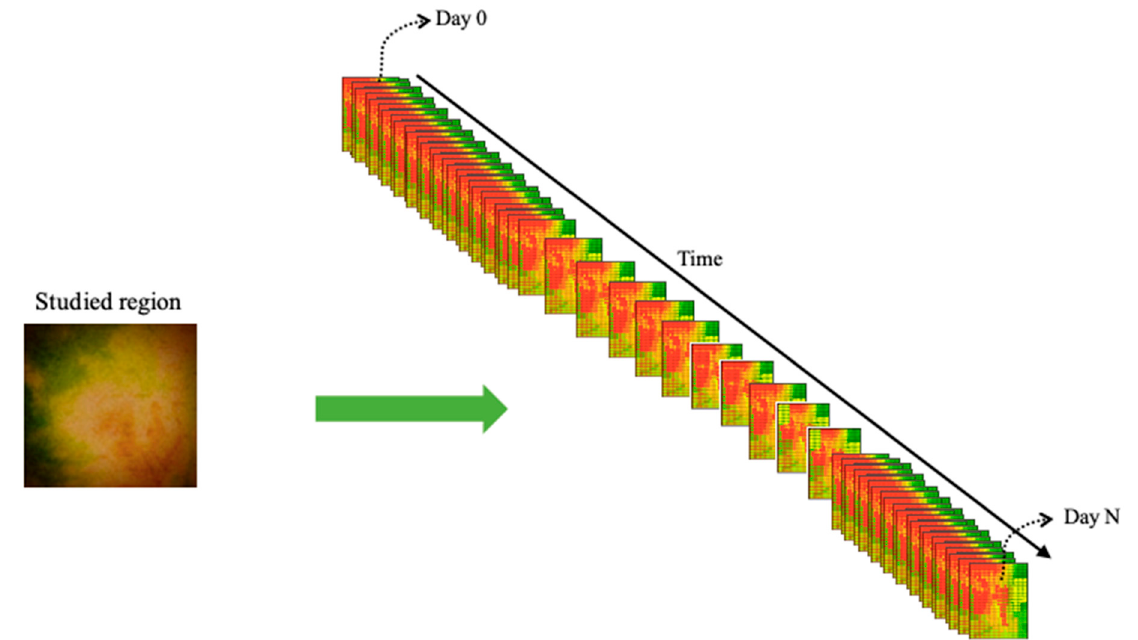
Figure 2. Spatio–temporal rasters representing the evolution of the temperature during N days for a studied region.